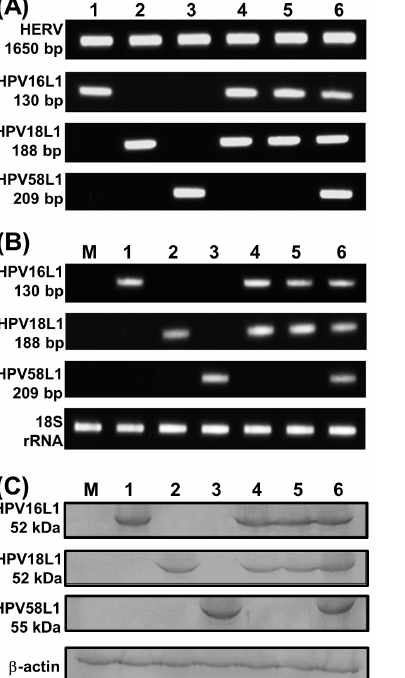
Figure 3. Chracterization of AcHERV-based nanovaccines and expression of HPV L1s. AcHERV-based nanovaccines were generated by amplification of HERV env and HPVL1 genes from viral DNA (A) for recombinant AcHERV-HP16L1 (lane 1), AcHERV-HP18L1 (lane 2), AcHERV-HP58L1 (lane 3), AcHERV-HP16/18L1 (lane 4), AcHERV-HP18/ 16L1 (lane 5), and AcHERV-HP16/18/58 L1 (lane 6) using specific PCR primers. Expression of HPVL1 genes was performed RT-PCR (B) and western blot (C) in 293TT cells infected with for recombinant AcHERV- HP16L1 (lane 1), AcHERV-HP18L1 (lane 2), AcHERV-HP58L1 (lane 3), AcHERV-HP16/18L1 (lane 4), AcHERV-HP18/16L1 (lane 5), and AcHERV- HP16/18/58 L1 (lane 6). Lane M is uninfected 293TT cells.